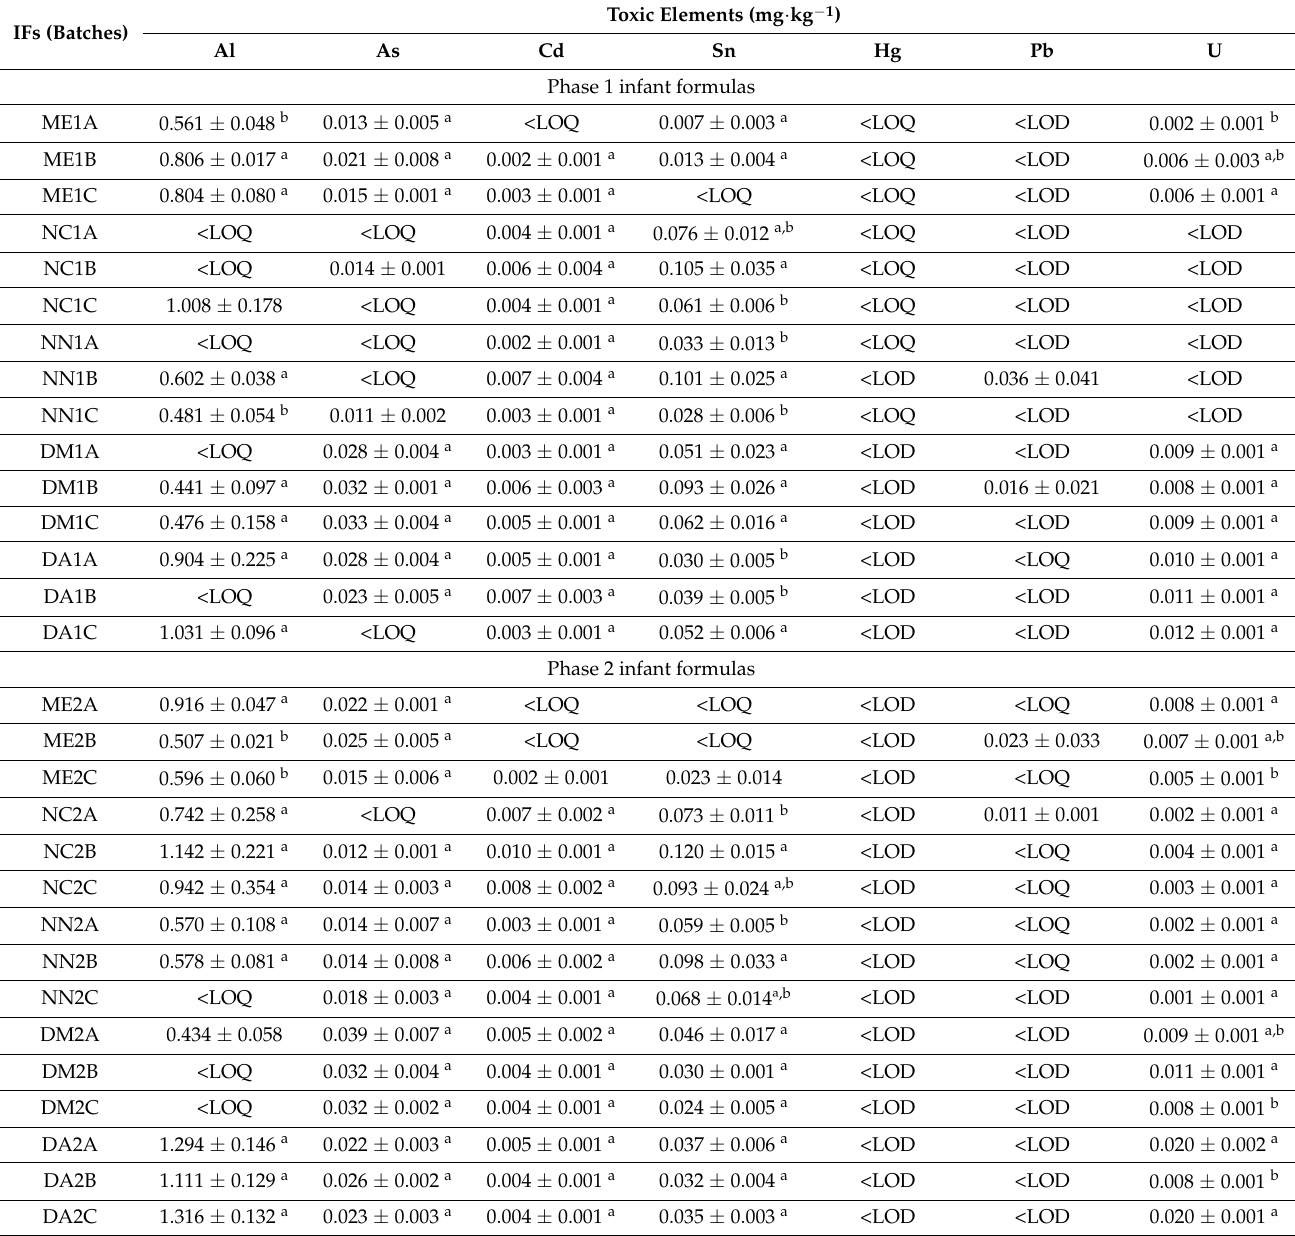
Table 4. Average concentrations of toxic metals and metalloids in phase 1 and phase 2 infant formula in distinct